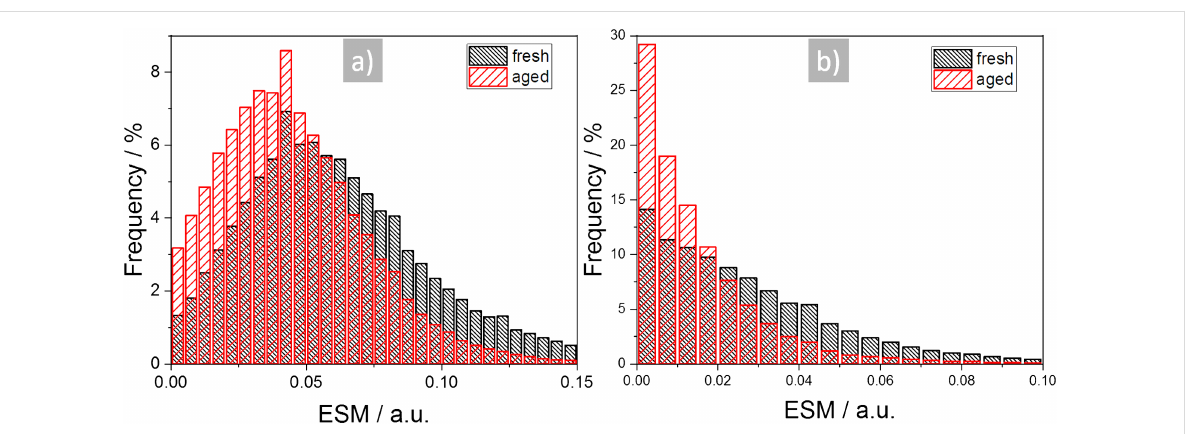
Figure 6: Comparison of ESM signal intensity of the fresh and aged cathode due to the a) positive and b) negative dc-voltage